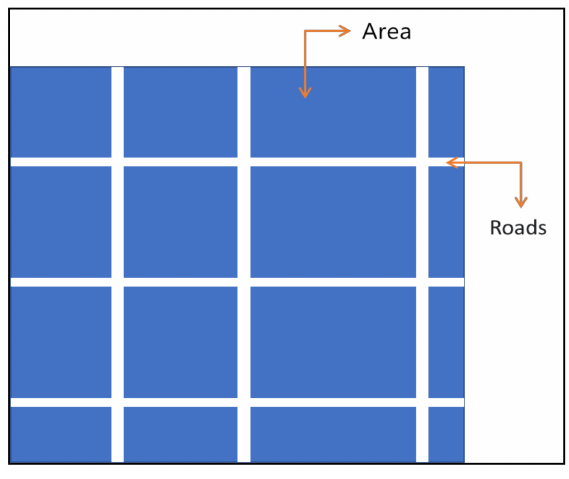
Figure 1. A road-separated area.